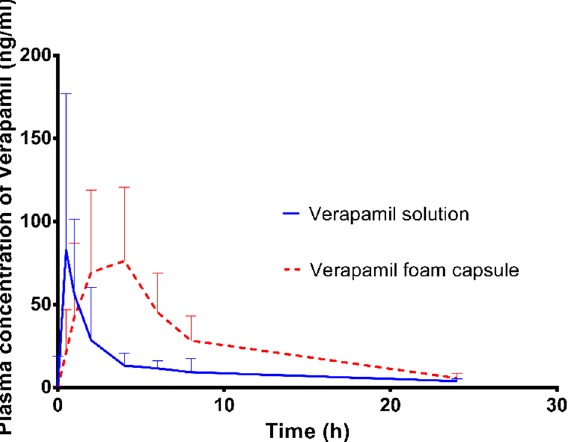
Figure 11. Mean plasma Verapamil–HCI concentrations and standard deviations after a single oral dose of the reference solution and foam capsule were administered to beagle dogs (n = 6). After 4 h, the capsule was eliminated from the stomach (Figure 12b).